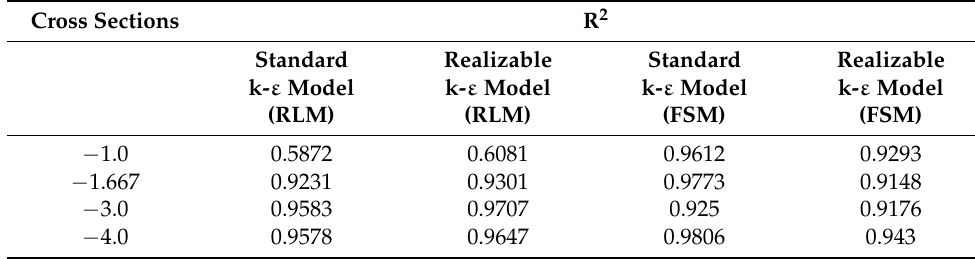
Table 6. R 2 values of the resultant velocities as shown in Figure